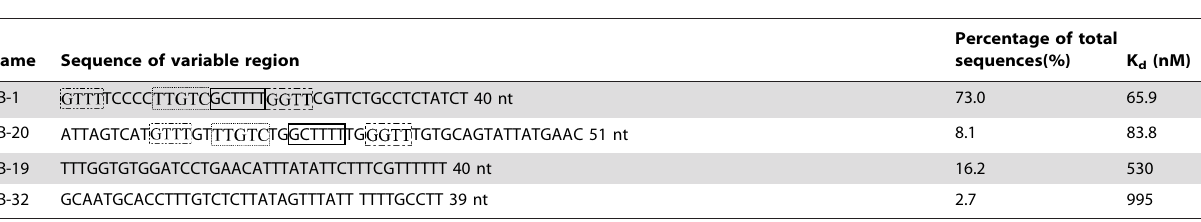
Table 1. Sequences of selected aptamers and their dissociation constants (K d ).